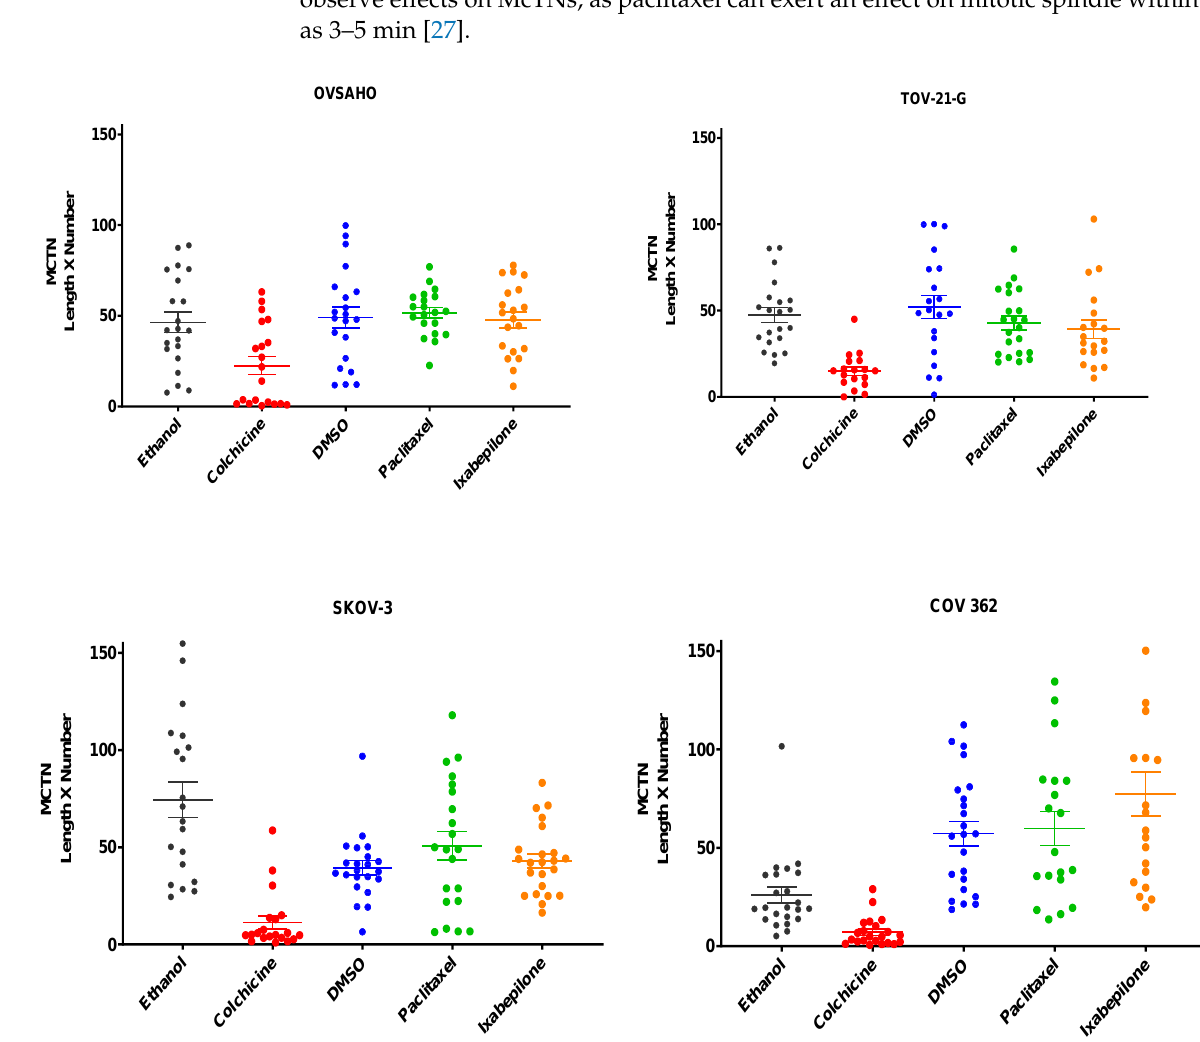
Figure 4. Effect of colchicine ( red ), paclitaxel ( green ), and ixabepilone ( orange ) on McTN morphology (length × number) in OSC (OVSAHO, SKOV-3, COV-362) and OCCC (TOV-21-G) lines ( n =20). Mean and standard error of the mean are shown.